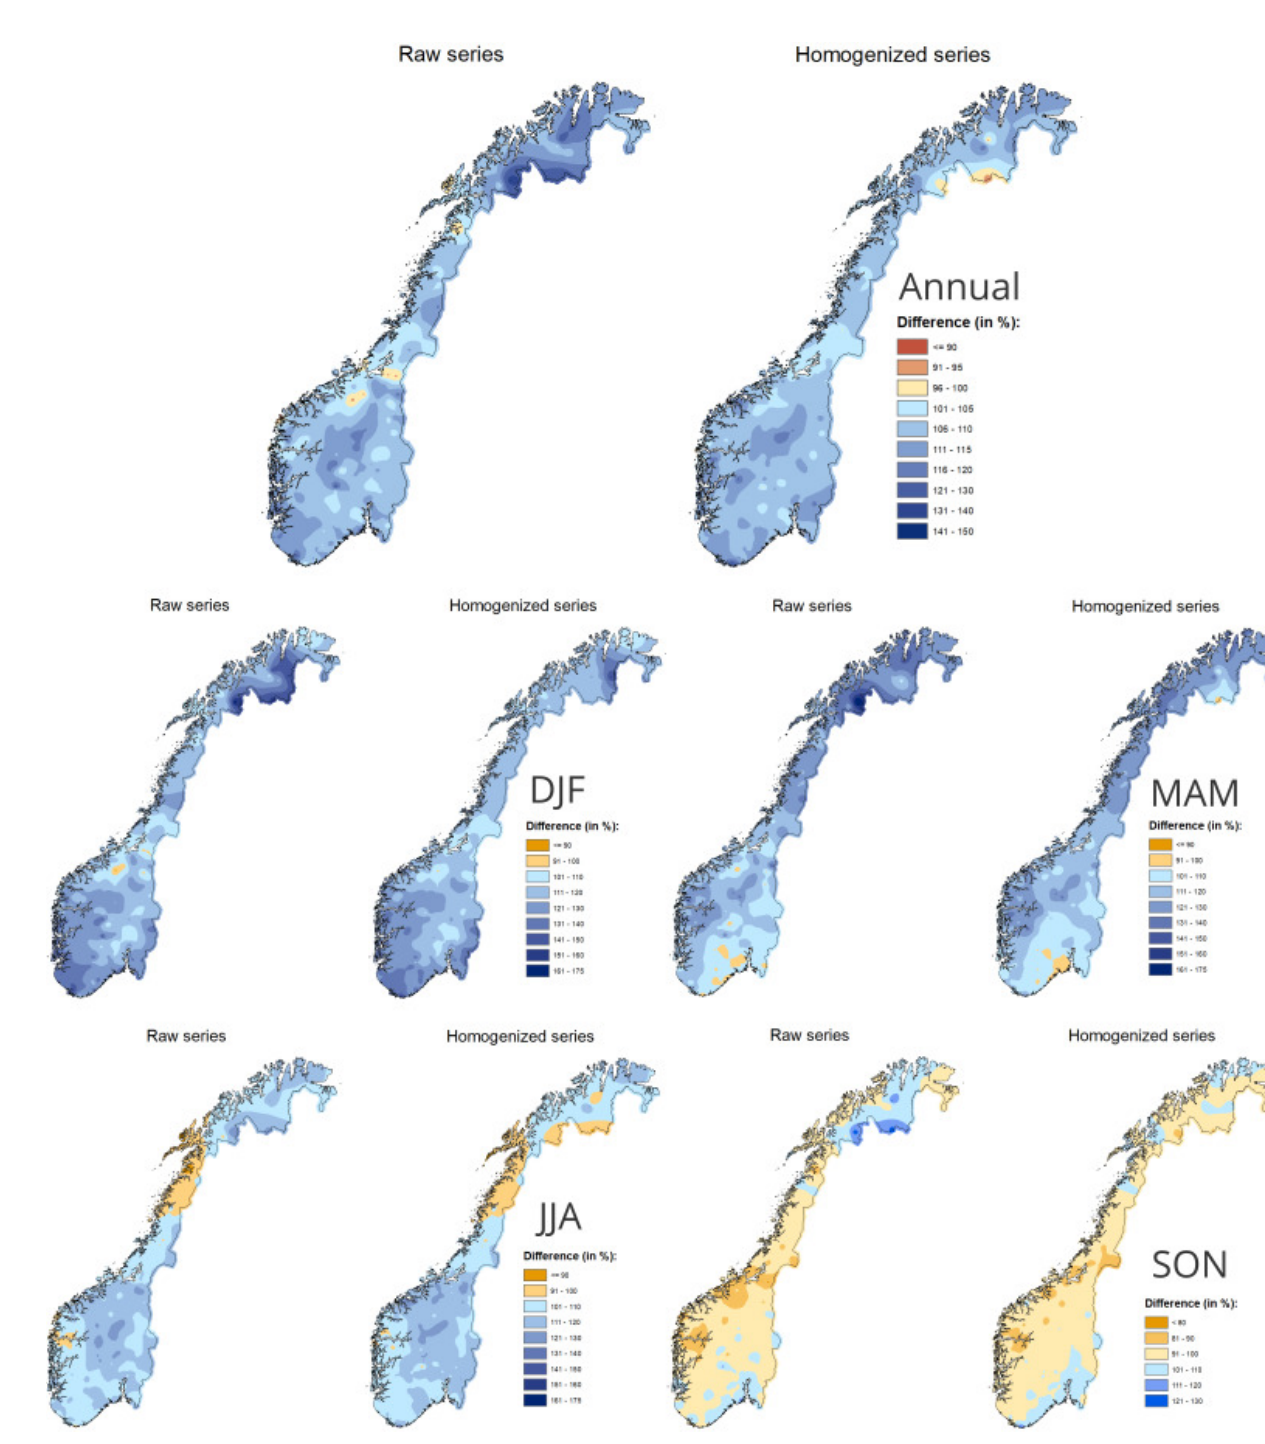
Figure 4. 1991–2020 normal values in percent of the 1961–1990 normal for raw and homogenized annual and seasonal series.